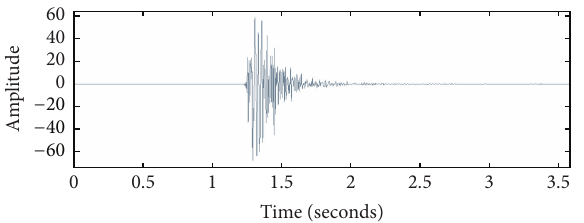
Figure 10: The analyzed real seismic signal with single